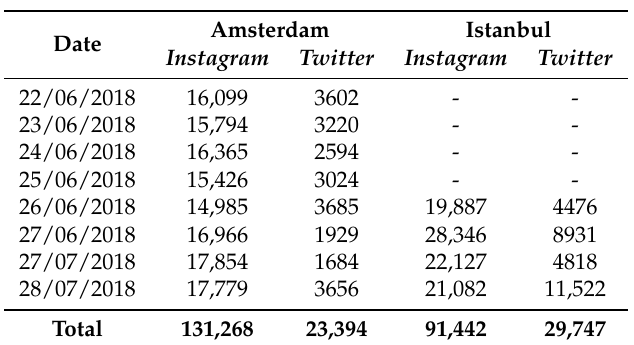
Table 6. Number of collected social media posts per